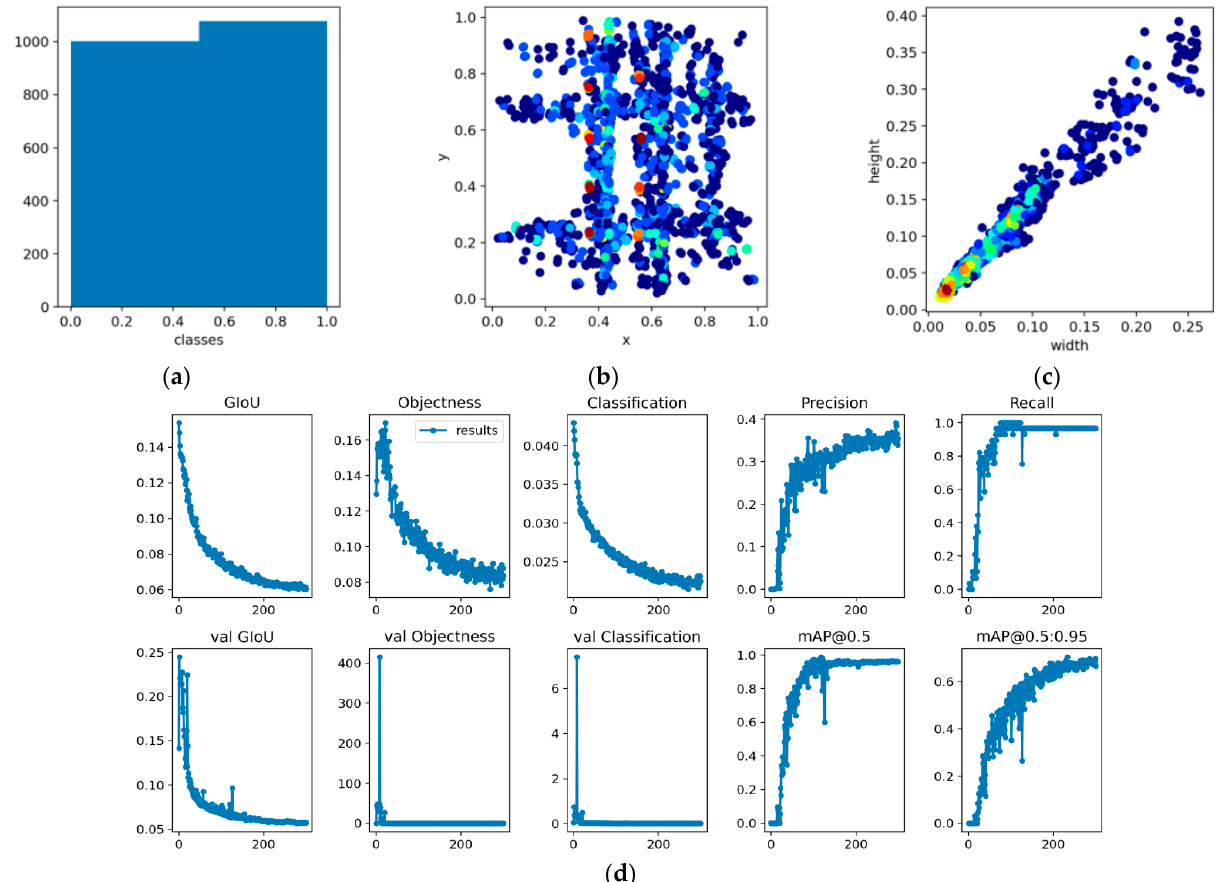
Figure 4. Sample analysis and model training results. ( a ) Samples number. ( b ) Objects coordinate distribution. ( c ) Statistical chart of sample box length-width ratio. ( d ) Training